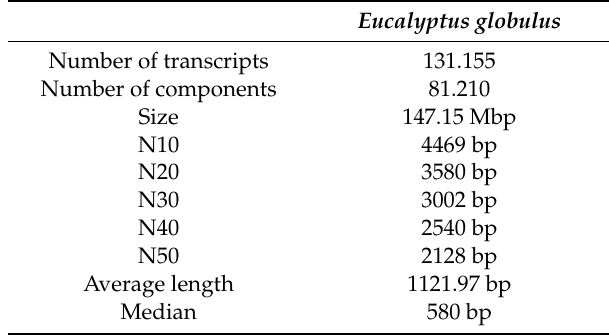
Table 1. Summary of de novo assembly statistics of Eucalyptus globulus roots by Trinity software.